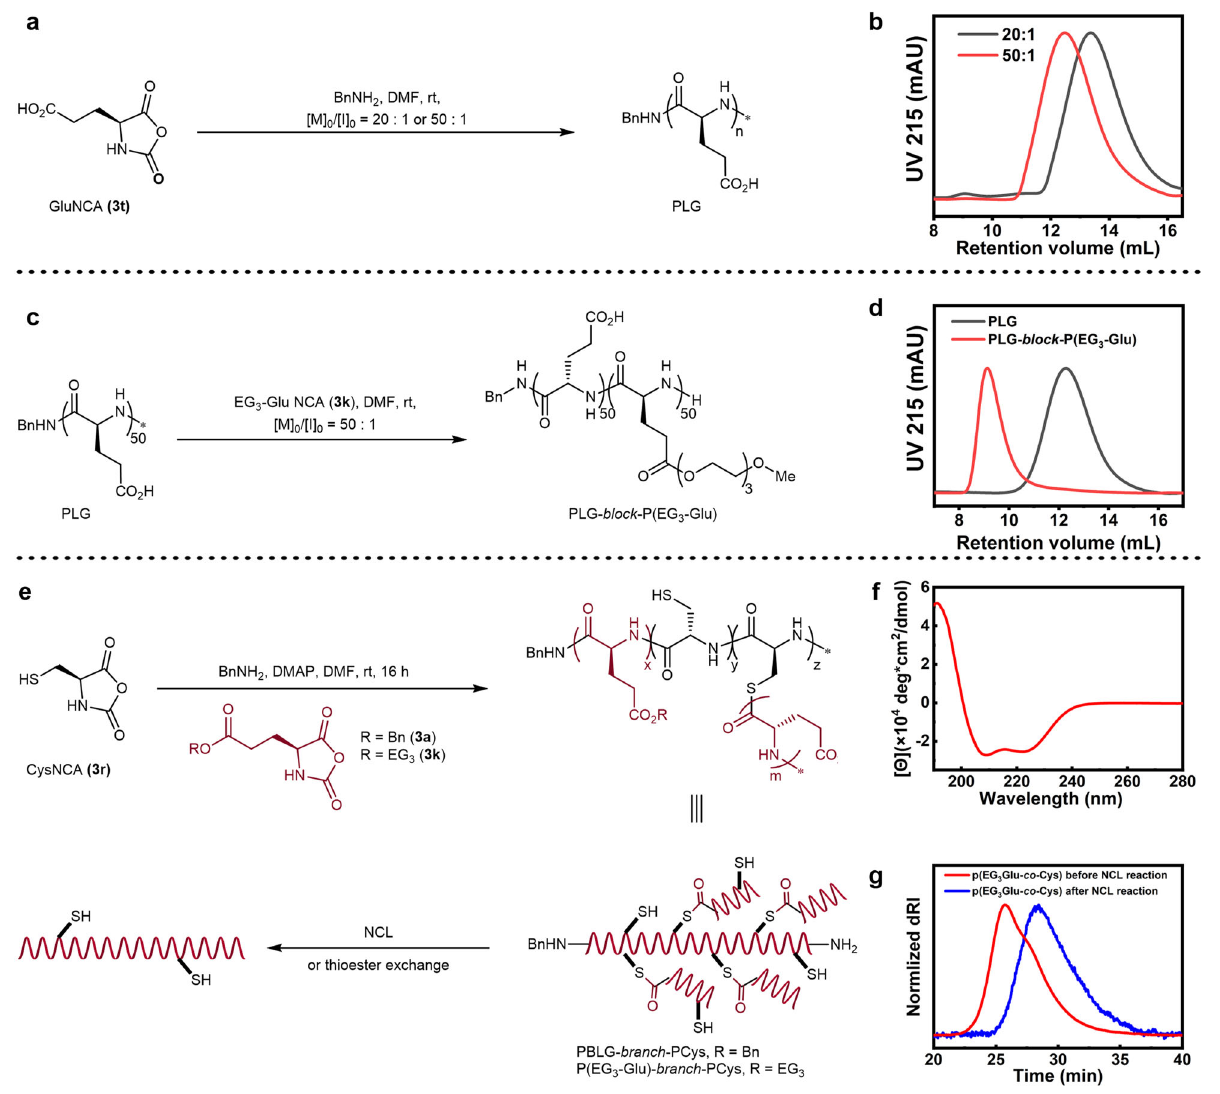
Fig. 5 Homo- and co-ROP of GluNCA and CysNCA. a , b Synthetic scheme ( a ) and SEC ( b ) characterization of PLG via the direct ROP of GluNCA at a feeding monomer/initiator ratio of 20/1(black trace) and 50/1 (red trace). The M n values reported here were obtained from a SEC equipped with a multi- angle light scattering detector and a refractive index detector. mobile phase: 50 mM NaH 2 PO 4 , pH = 9 in H 2 O; fl ow rate of 0.5 mL/min; d n /d c of PLG = 0.1184 ± 0.002859 mL/g). c , d Synthetic scheme ( c ) and SEC ( d ) characterization of the block polymer PLG- block -P(EG 3 -Glu). e – g Synthetic scheme ( e ), CD ( f ), and SEC in DMF ( g ) characterization of P(EG 3 -Glu)- branch -PCys (red trace) via the ROP of EG 3 GluNCA and CysNCA. The blue trace in ( g ) represents the partially degraded polypeptides after native chemical ligation